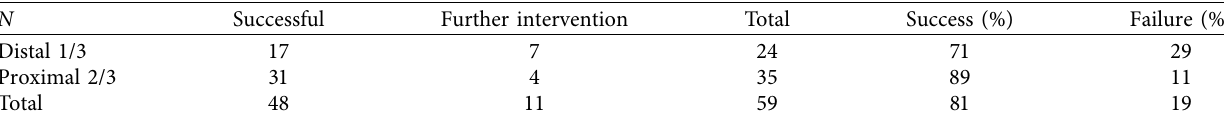
Table 1: Summary of the